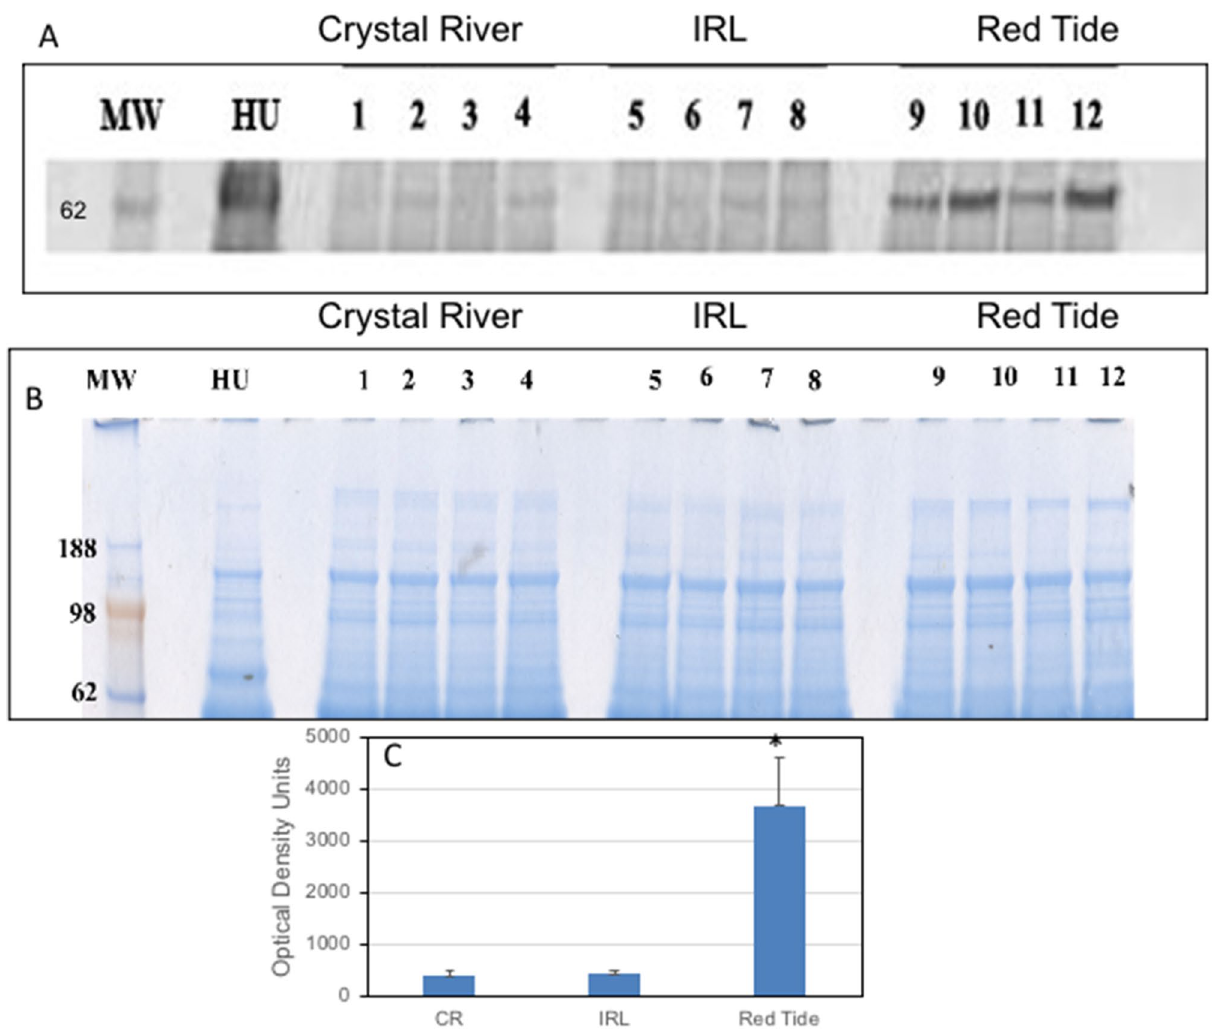
Figure 2. Confirmation of up regulation of Protein C4-A in the serum of manatees from the red tide group. (A) Western blot of protein electro transferred to a PVDF membrane and probed with rabbit anti-human protein C4 antibody [N1N2-2]. (B) Corresponding Coomassie blue stained gel showing equal loading of proteins in the wells. (C) ImageJ quantification of bands in the Western blot. *Statistical significance at p-value < 0.05. The original gel and blot are shown if supplementary Fig.